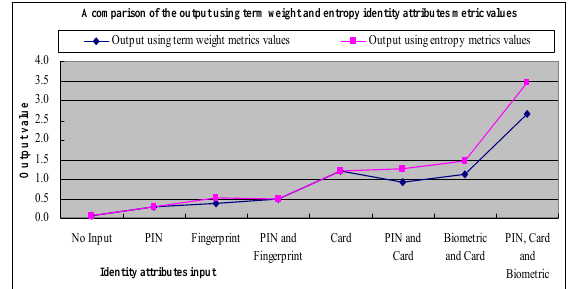
Fig. 4. A comparison of the output values generated by the FIS information fusion technique using term weight and entropy identity attributes metrics values. Fig. 3. Surface viewer for the pseudo metrics input, the device